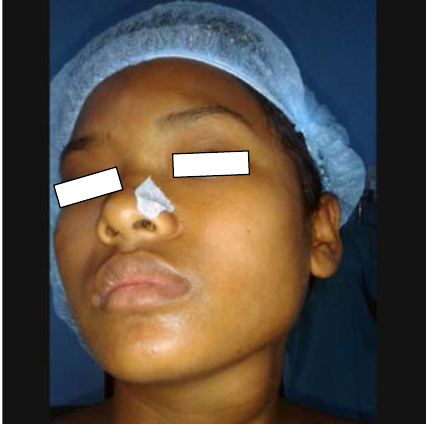
Figure 1: Preoperative photograph showing mass in the left sided upper neck.